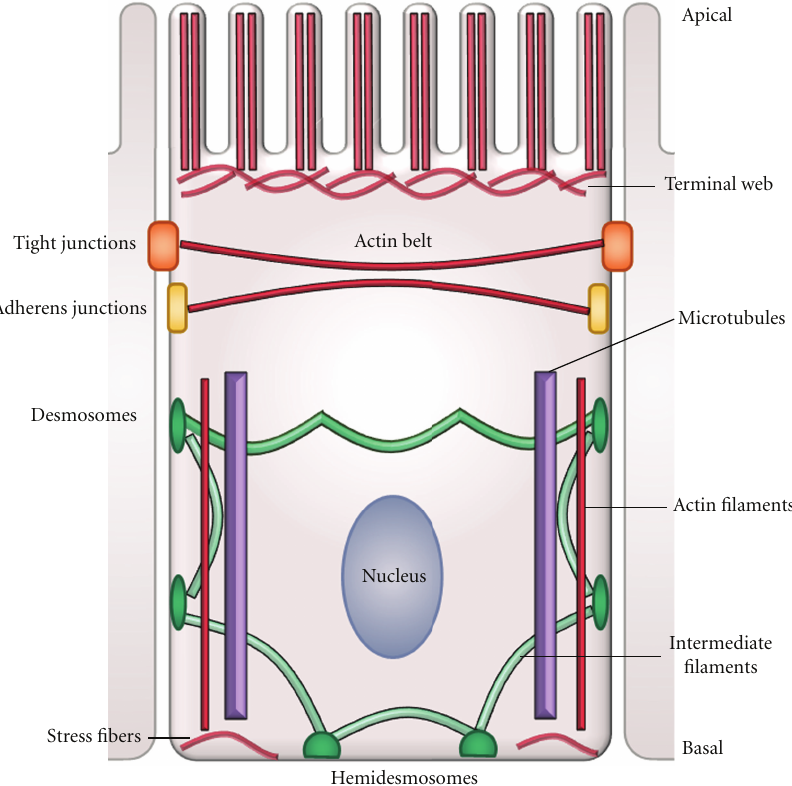
Figure 1: Schematic representation of the cytoskeletal organization of a transporting epithelial cell. The scheme shows the cell-cell and cell-substrate junctions connecting the actin, tubulin, and intermediate filament cytoskeletons. See text for